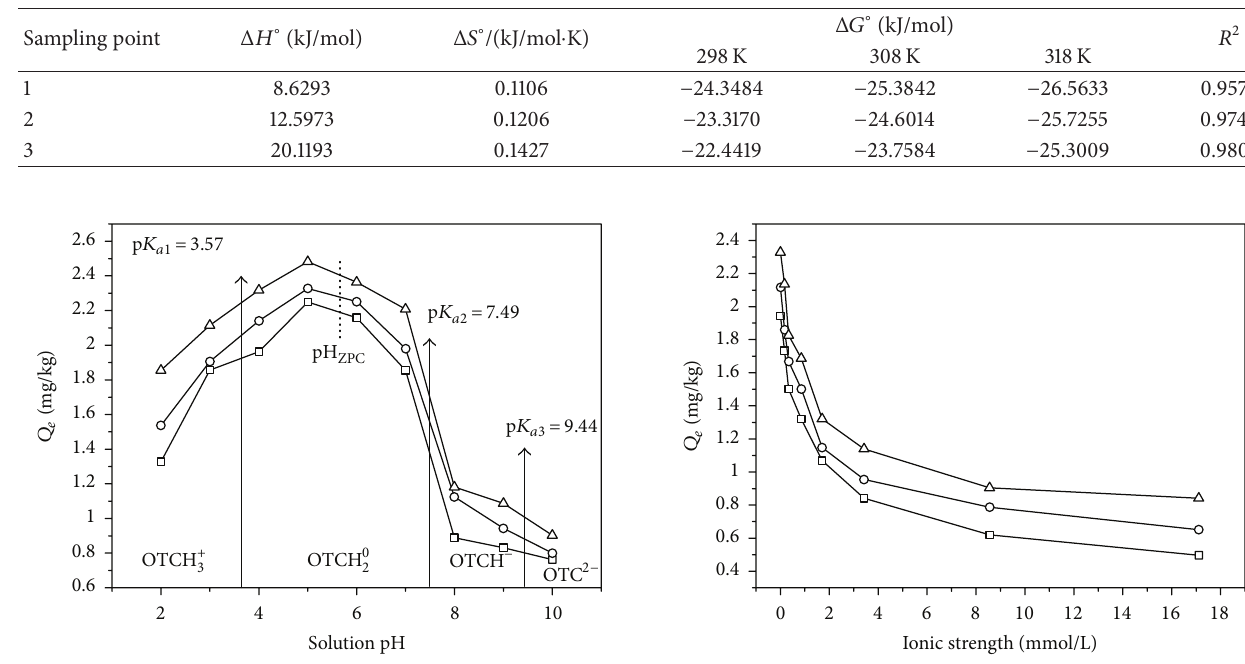
Table 6: Thermodynamic parameters for OTC adsorption onto sediment samples.